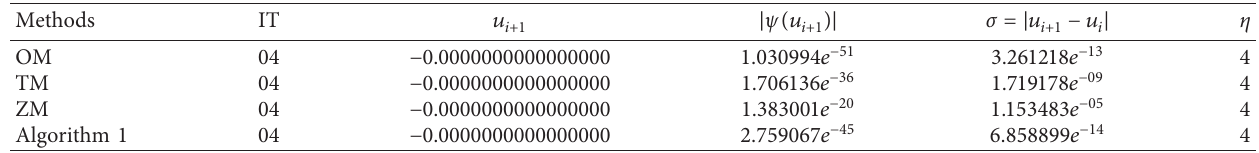
Table 4: Comparison among different fourth-order algorithms.